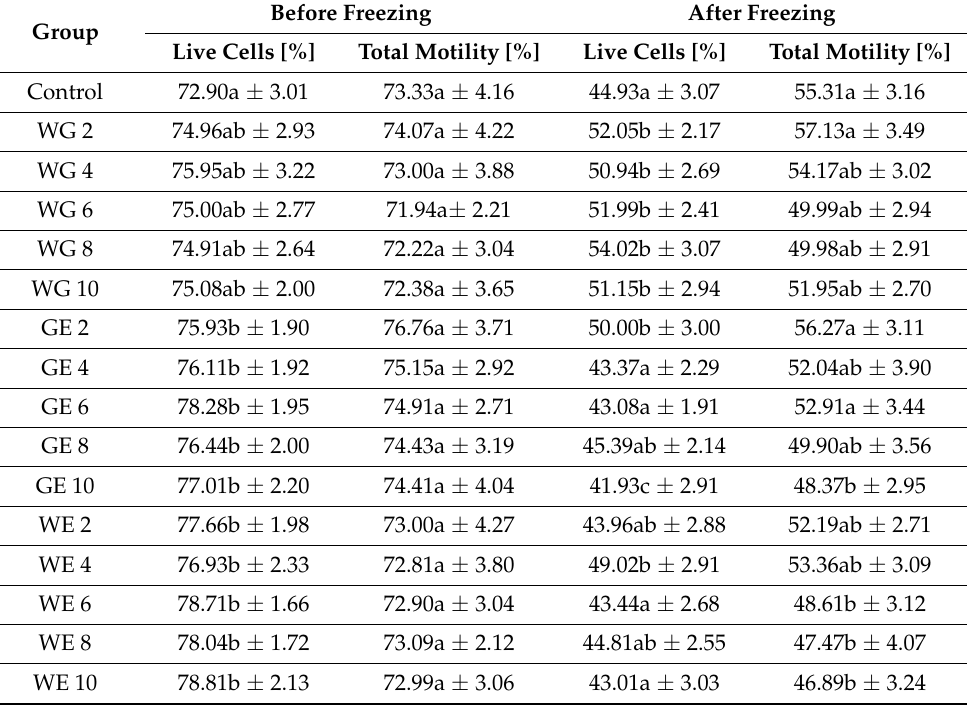
Table 1. Effect of various types of sea cucumber extract on viability and total motility of spermatozoa before and after cryopreservation. Explanations: a–c—means with different superscript letters in the same column differ significantly at p <